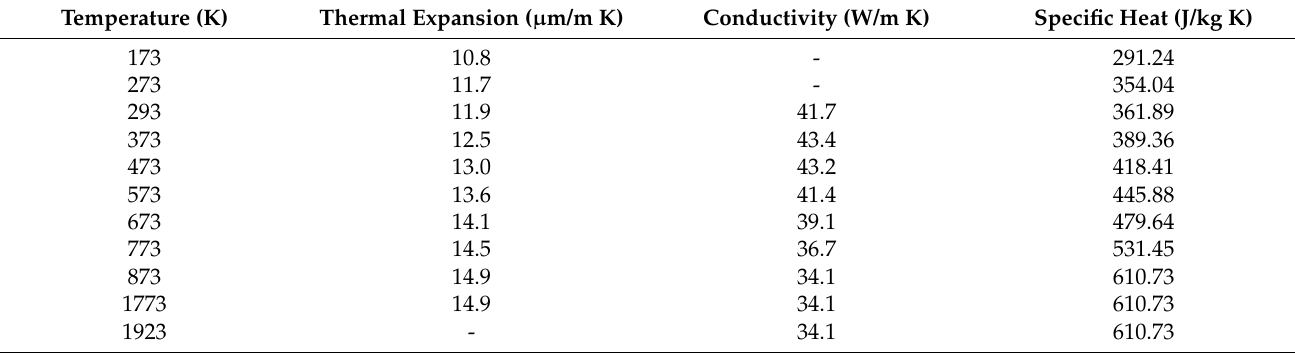
Table 4. Thermal expansion, conductivity, and specific heat of DIN 42CrMo4, depending on the temperature [22]. Temperature (K) Thermal Expansion ( µ m/m K) Conductivity (W/m